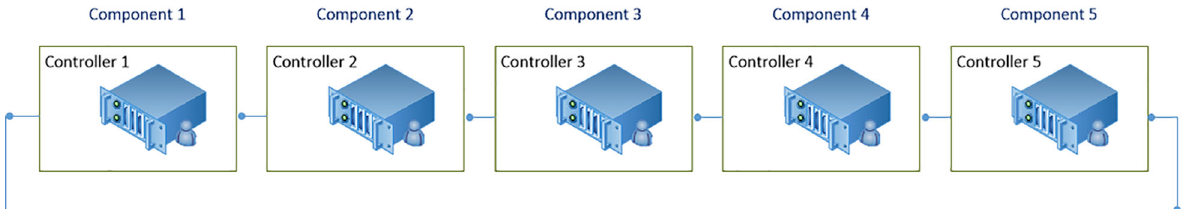
Fig. 2. Process control in a CPPS